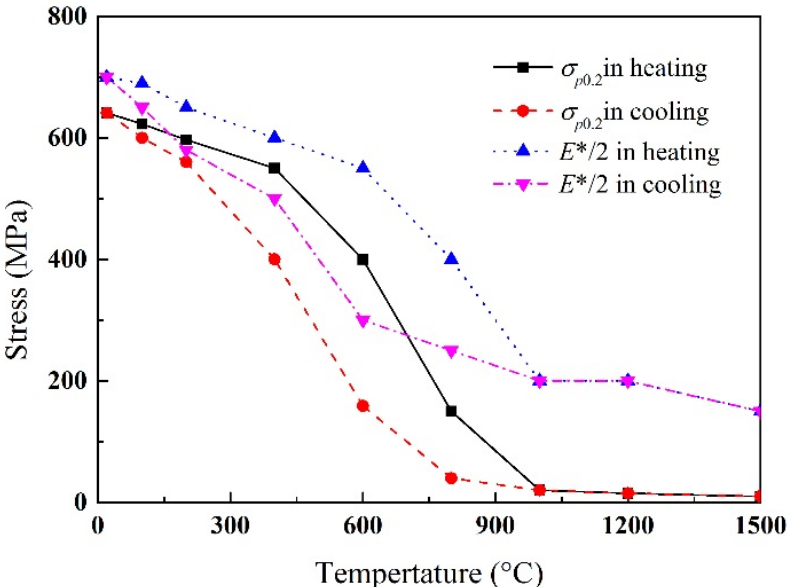
Figure 6. Yield strength and hardening modulus.